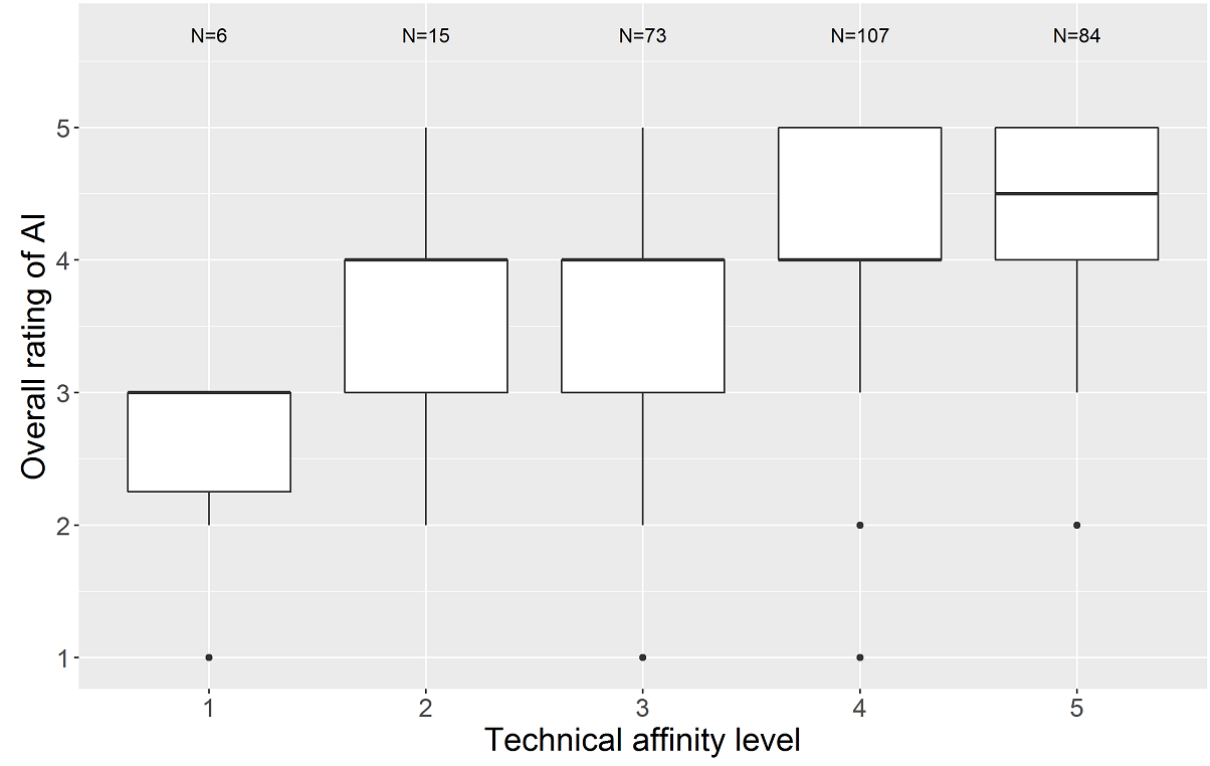
Figure 4. Personal rating of artificial intelligence (AI) stratified by technical affinity